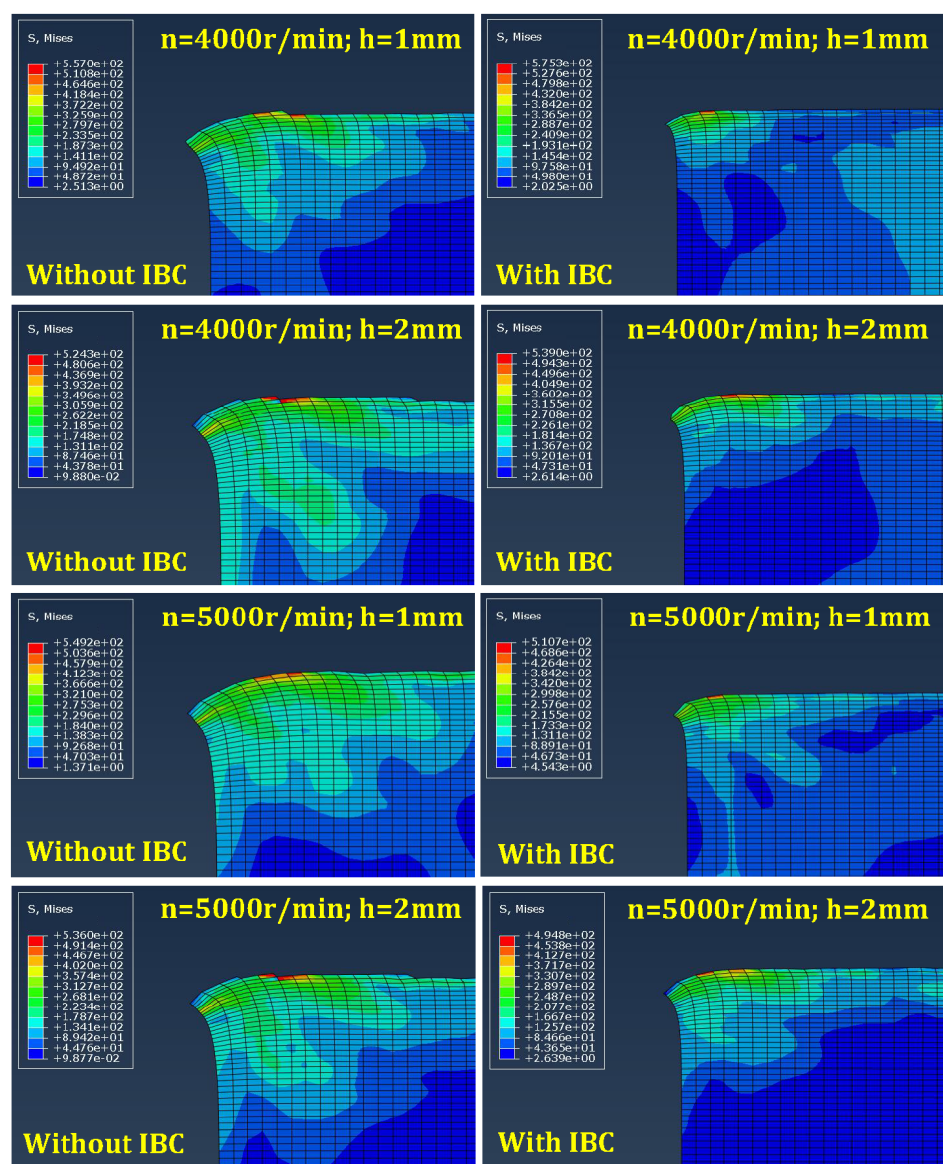
Figure 4. Simulation results of exit burrs height.